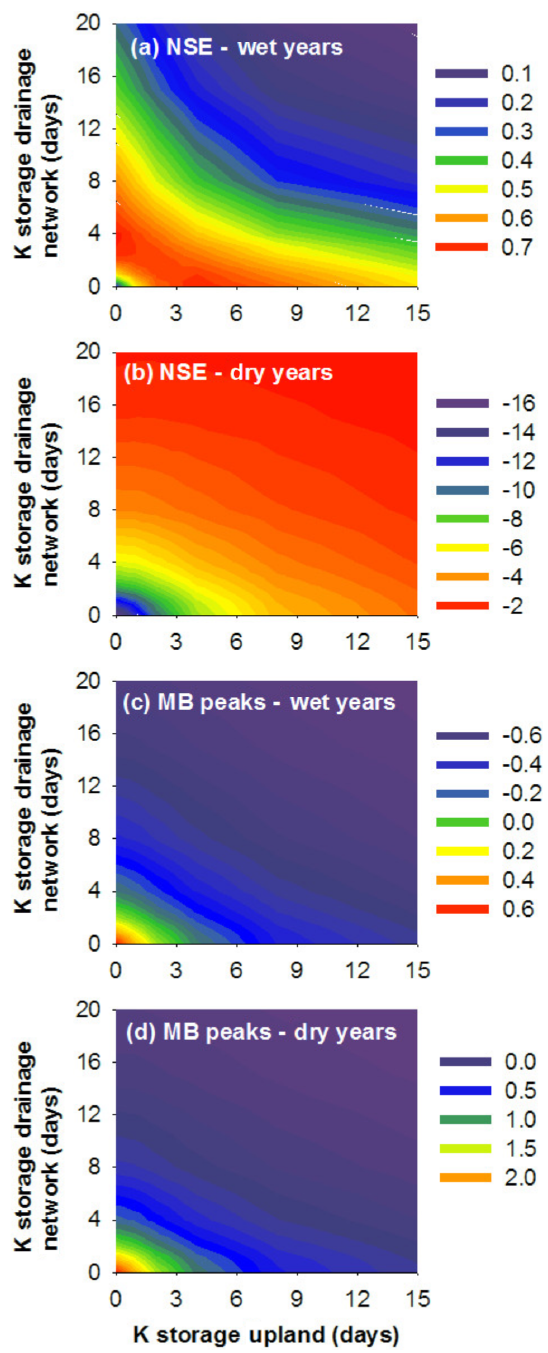
Figure 9. Sensitivity analysis of the K storage parameter in the Muskingum model for the upland areas and drainage network us- ing the Nash–Sutcliffe efficiency (NSE) and peak-flow model bias (MB) as objective